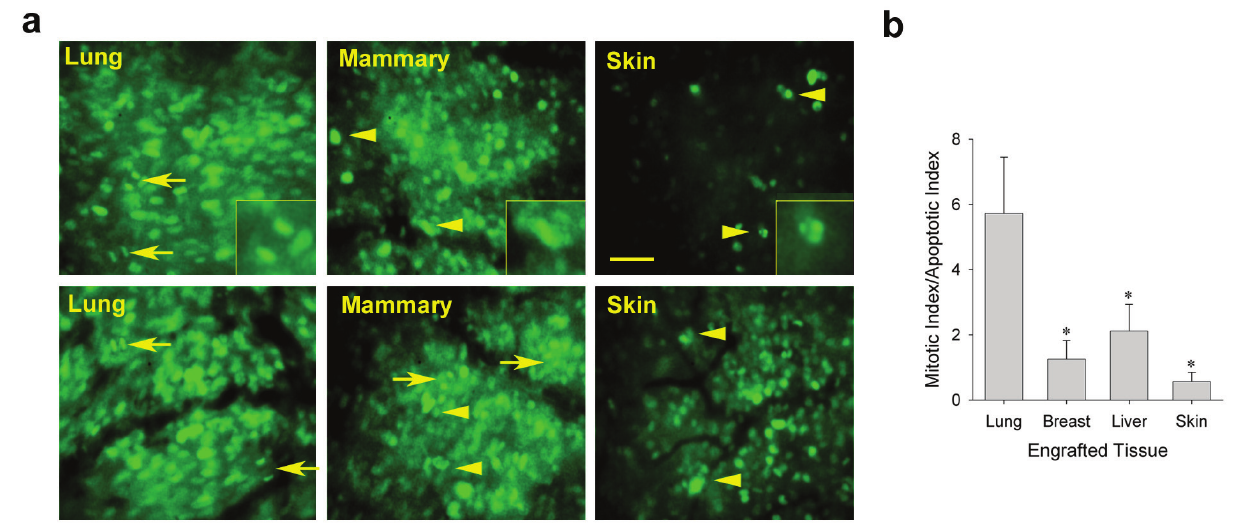
Figure 5. Effect of tissue co-engraftment on mitotic/apoptotic indices of tumor cells. ( a ) Higher magnification fluorescence micrographs showing LLC tumor cells growing in indicated tissues (9 days post-implantation) to assess their effect on relative tumor cell mitosis and apoptosis. Mitotic (arrows) and apoptotic (arrowheads) cells were counted to determine the ratio of mitotic cells to apoptotic cells ( b ). Scale bar = 100 μm. Mean +/- SD are shown. * = p<0.05. n = 3–4 mice for all